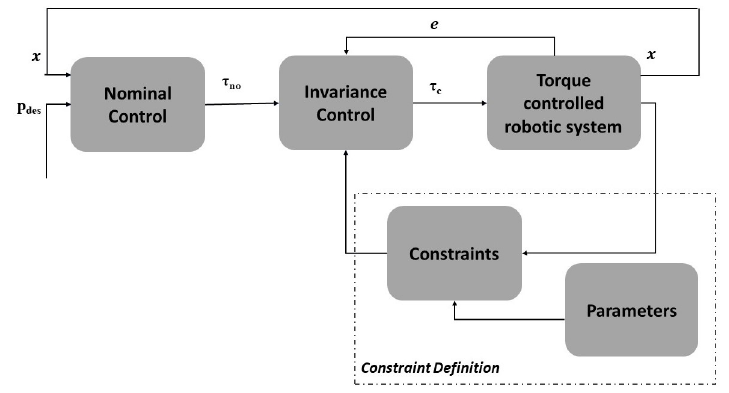
Figure 8. Invariance control